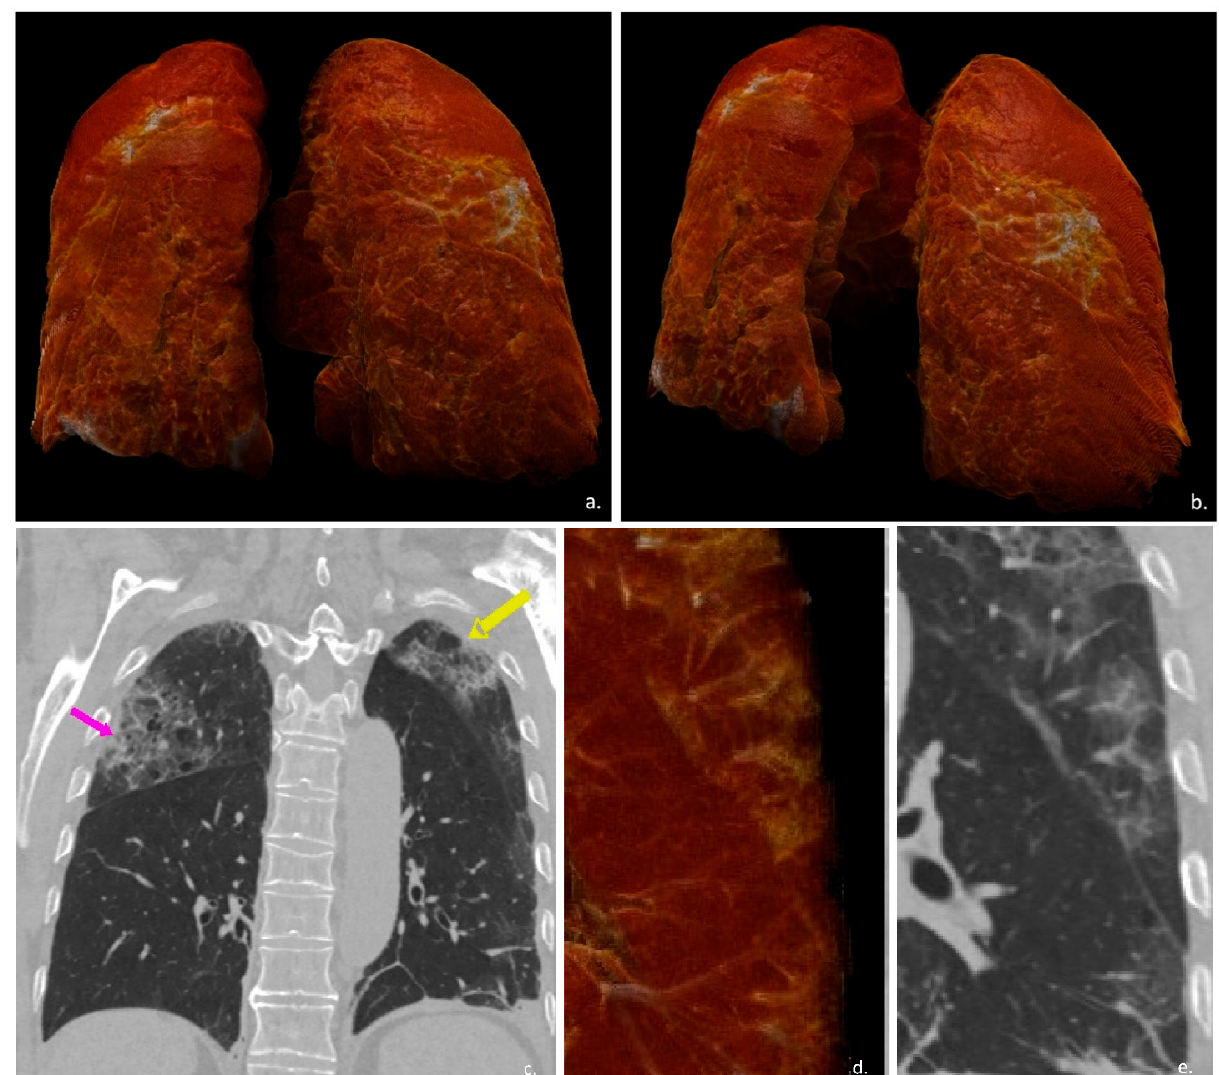
Figure 1. Automatic lung volume detection. Two different views from a volume-rendered reconstruction were obtained from the automatic detection of lung tissue (img ( a , b )). Pink and yellow arrows in img ( c ) highlight also high-density lesion within lung tissue, in a coronal view. In images ( d , e ), magnified, volume-rendered reconstruction and coronal CT scan view (respectively) enhance the high capability of CT and quantitative reconstruction to detect also millimetric lesion.